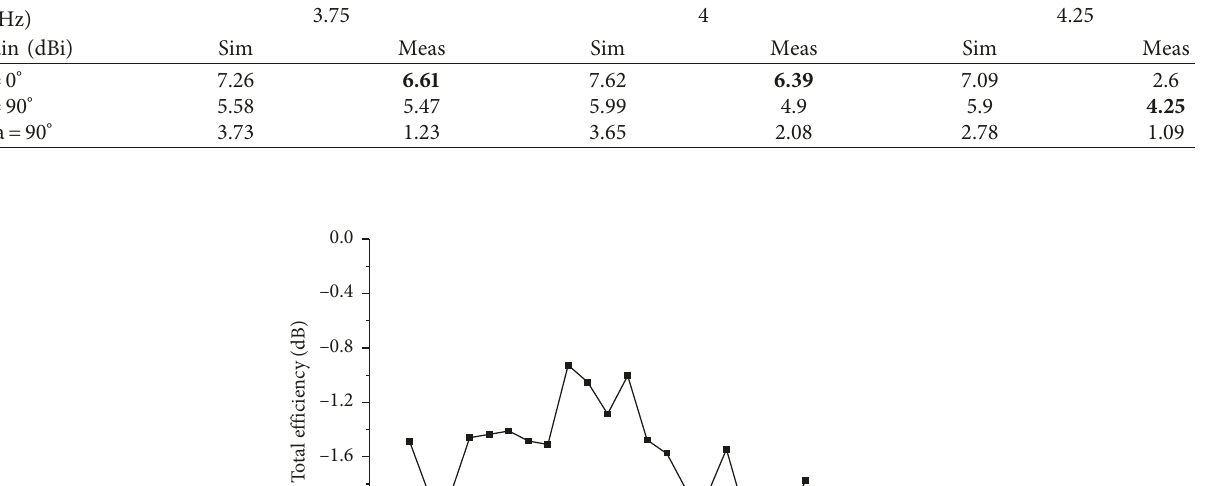
Table 3: Simulated and measured maximum realized gain of the cavity-backed prototype.